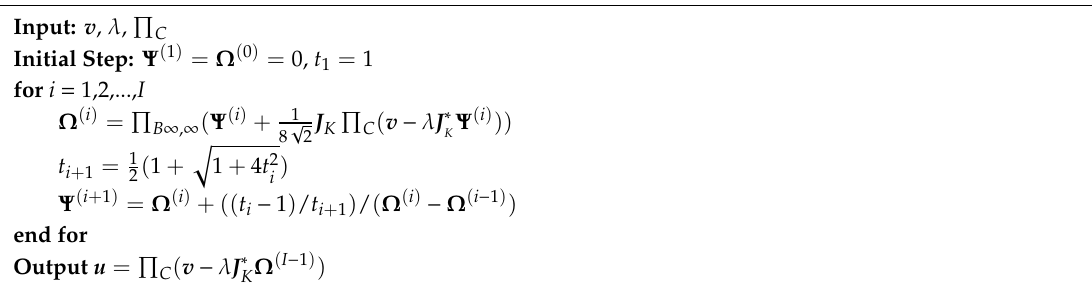
Algorithm 2 Workflow of the progressive proximal map algorithm